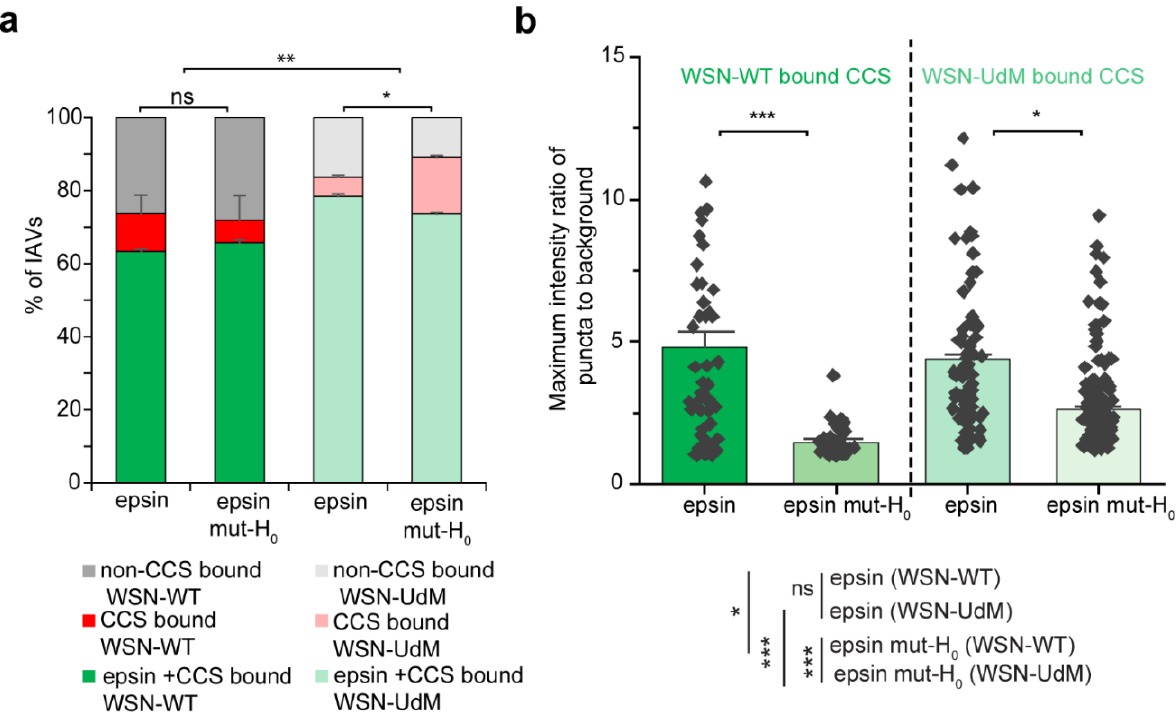
Figure 6. CCSs containing filament-forming IAVs strongly recruit epsin. ( a ) Percentage of WSN-WT and WSN-UdM particles bound to CCSs colocalizing with or without epsin or epsin mut-H 0 . ( b ) Maximum ratio of puncta intensity to background intensity of epsin or epsin mut-H 0 colocalized with IAV-containing CCSs. For a and b, N IAV tracks for WSN-WT in cells expressing epsin-EGFP, WSN-WT in cells expressing epsin mut-H 0 EGFP, WSN-UdM in cells expressing epsin-EGFP and WSN-UdM were 91, 105, 180, 225, respectively, and corresponding N cells were 18, 14, 15, 21 respectively. The error bars denote standard error. ns represent not significant. *, **, and *** represent p < 0.05, p < 0.01 and p < 0.001 respectively.